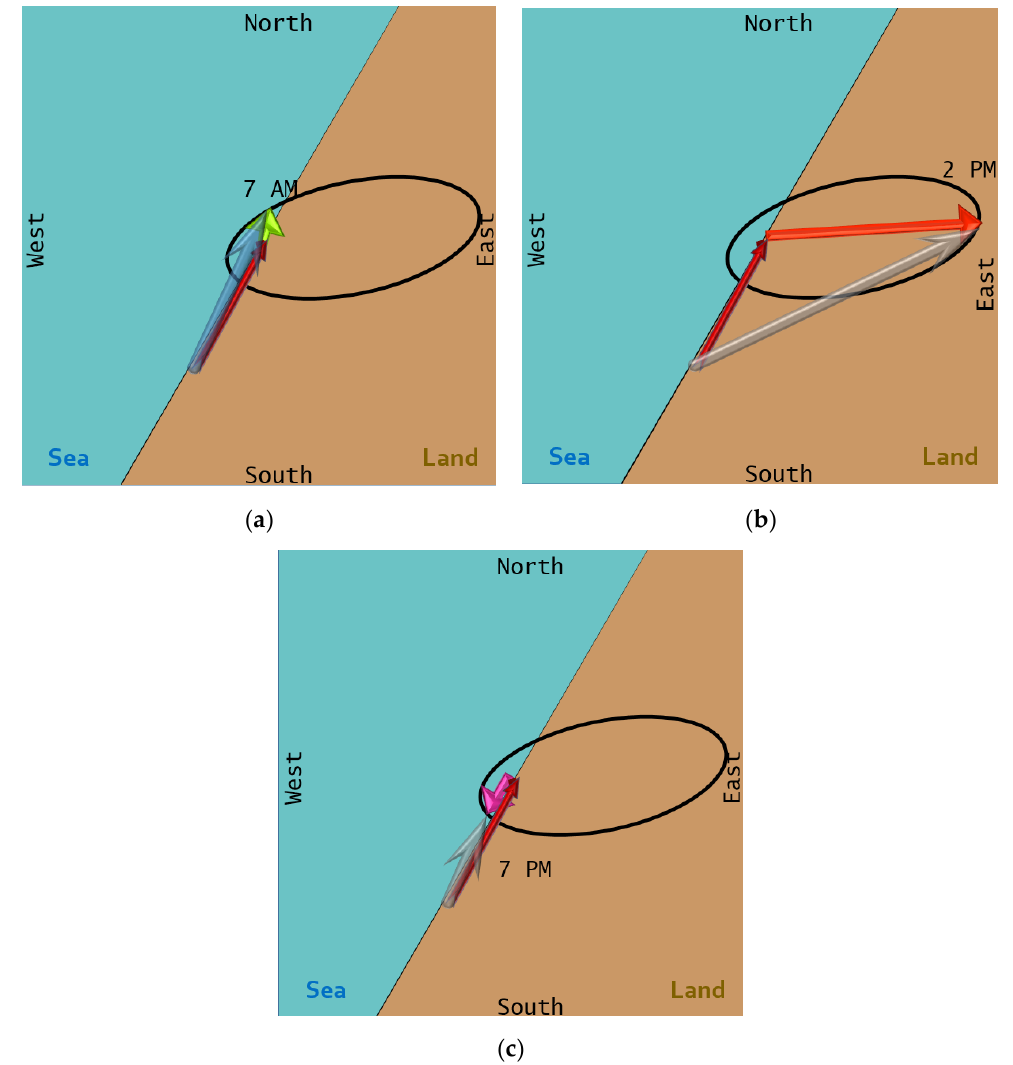
Figure 10. The blue arrows represent the southwest monsoon in summer. The land–sea breeze arrows rotate in the ellipse are shown with different colors for different times (7 AM, 2 PM, 7 PM) on a summer day. The gray arrows represent the wind speed resultant vectors composed of the land–sea breeze and the summer monsoon. ( a ) Resultant wind vector at 7 AM in June; ( b ) resultant wind vector at 2 PM in June; ( c ) resultant wind vector at 7 PM in June.